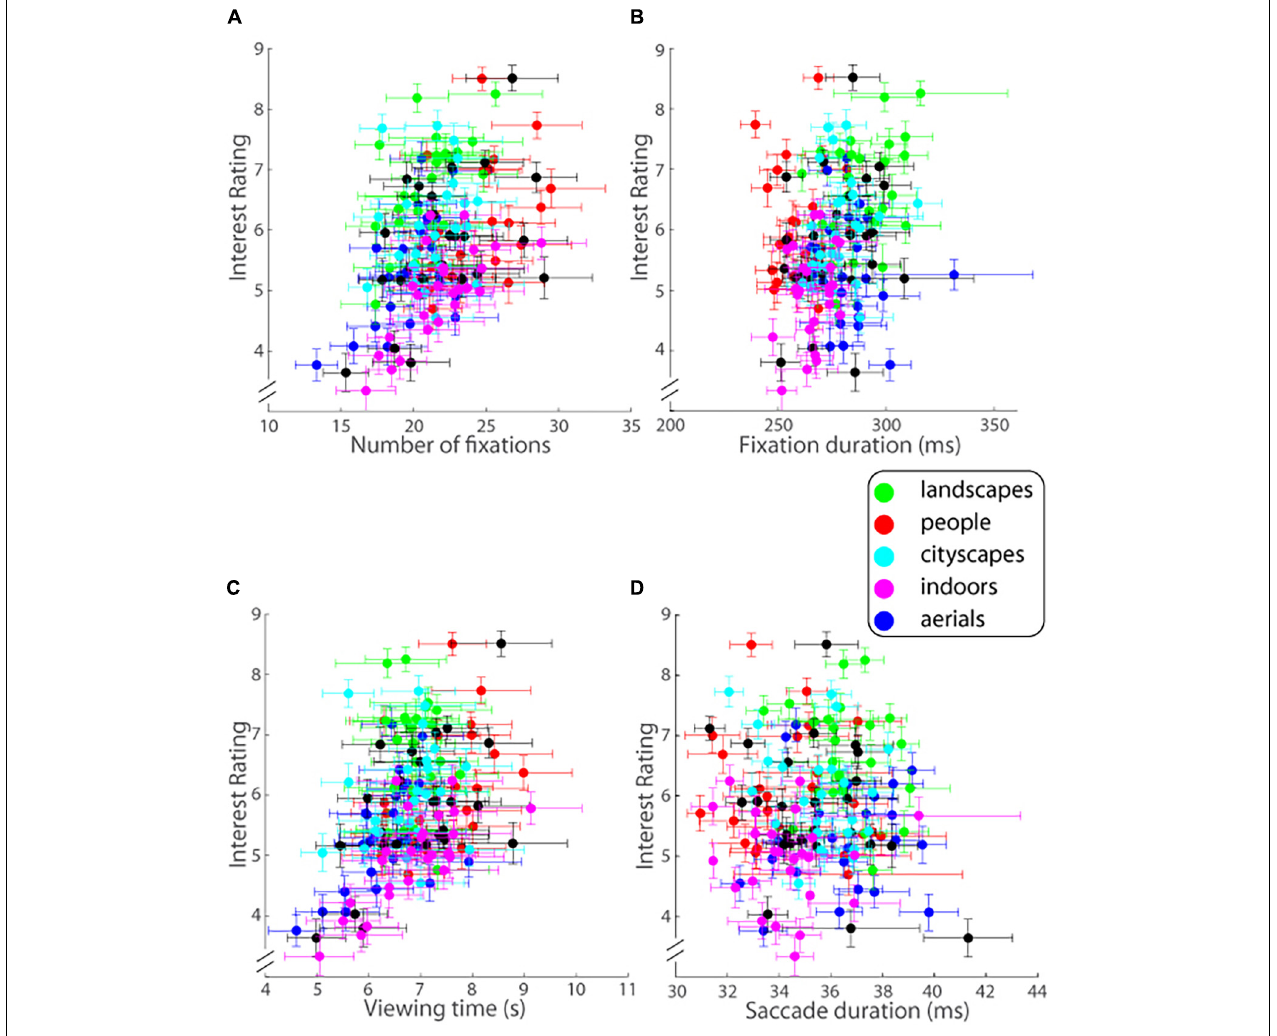
FIGURE 6 | Interest ratings on a ten-point scale (mean ± SEM.; ordinate) as a function of (A) number of fixations, (B) fixation duration, (C) viewing time, and (D) saccade duration (abscissa) for each image of each of the five image categories as well as the ALL mix bag (Experiment 1). Error bars are one